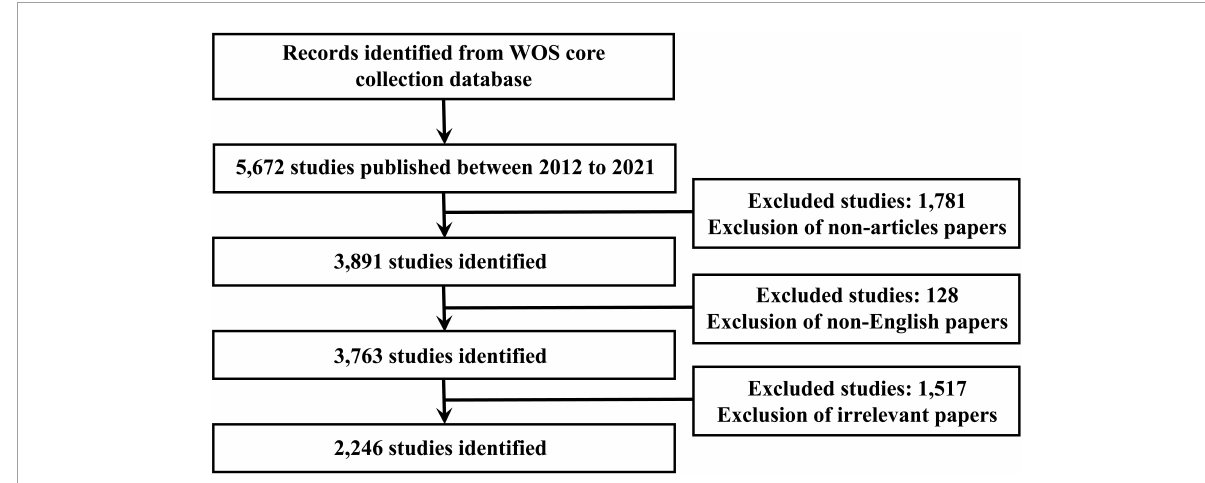
FIGURE1 Flow chart of literature screening related to PCa bone metastasis research.